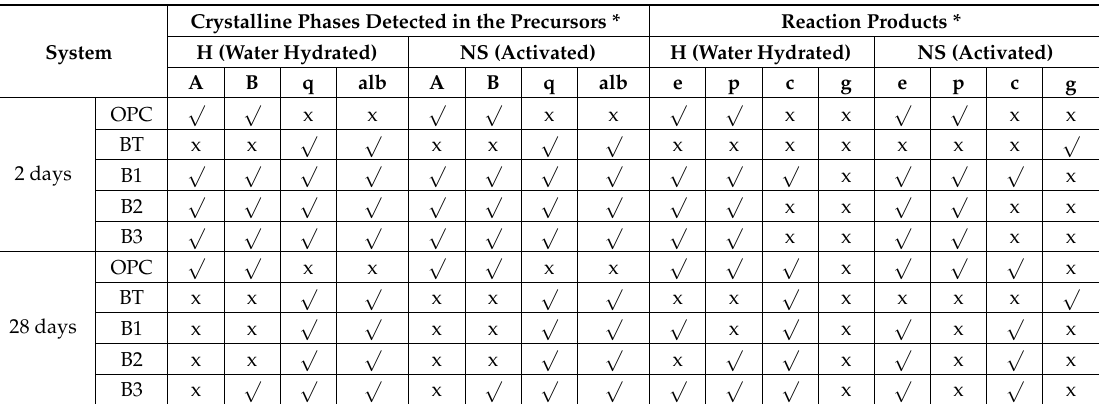
Table 2. XRD-detected crystalline